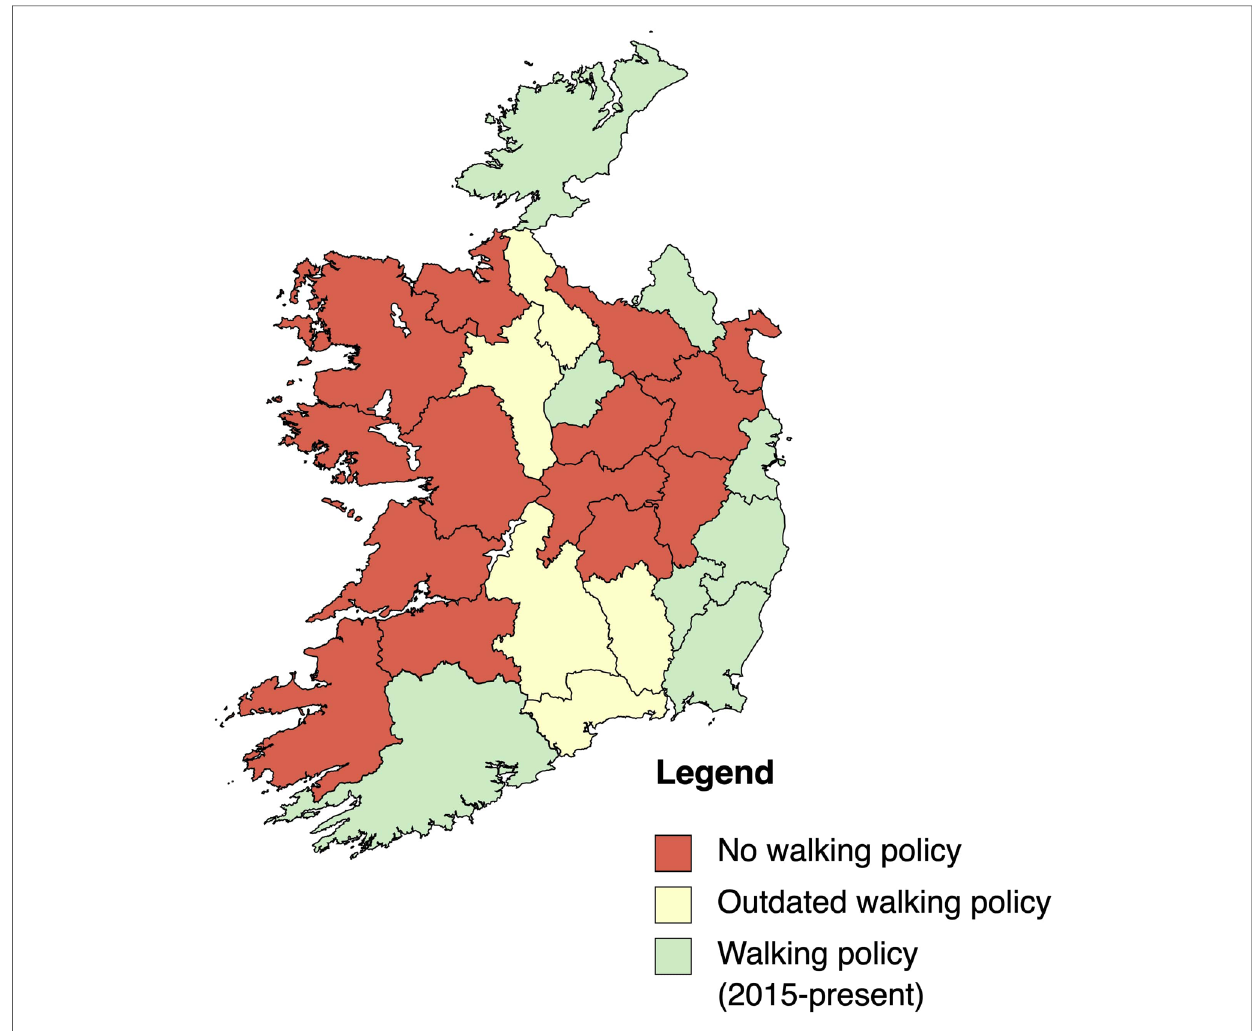
FIGURE 3 County by county breakdown of presence of walking policies. (Credit: